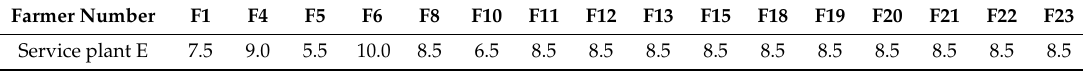
Table 7. Assessment of the selected service facility (service facility E).